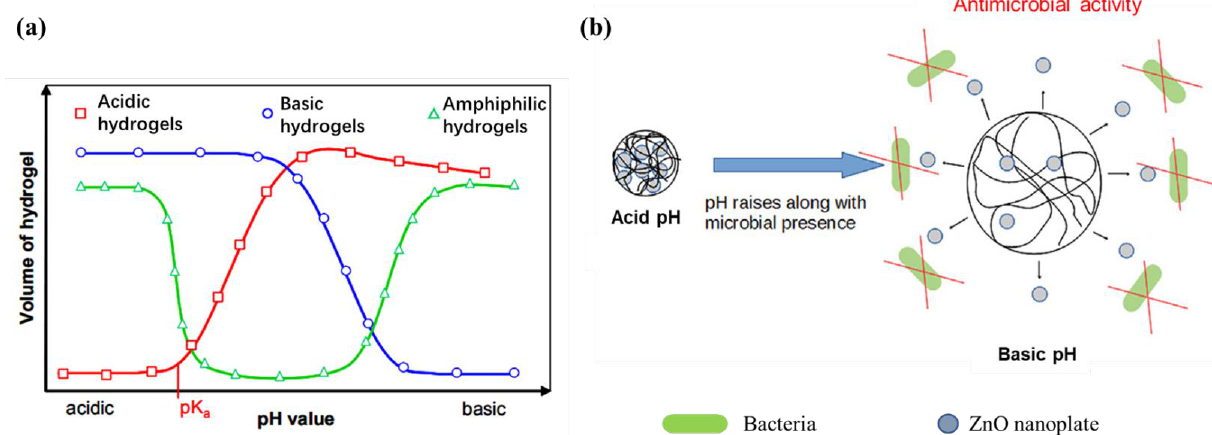
Figure 5. ( a ) pH-sensitive hydrogels volume change with the pH of solution; ( b ) The pH of the wound during bacterial metabolism is alkaline and the hydrogel swells to release ZnO nanoplate [86,87]. Reprinted with permission from Ref. [86]. Copyright 2008, copyright with permission from Andreas and Georgi. Reprinted with permission from Ref. [87]. Copyright 2018, copyright with permission from Villanueva and Cuestas.